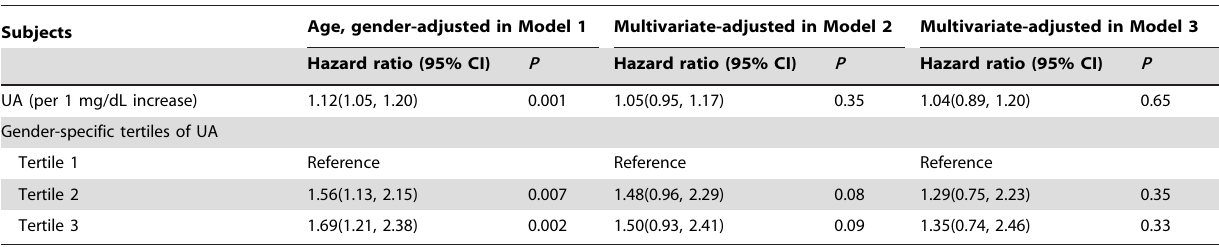
Table 3. The prognostic values of UA as continuous or categorical variable for cardiovascular